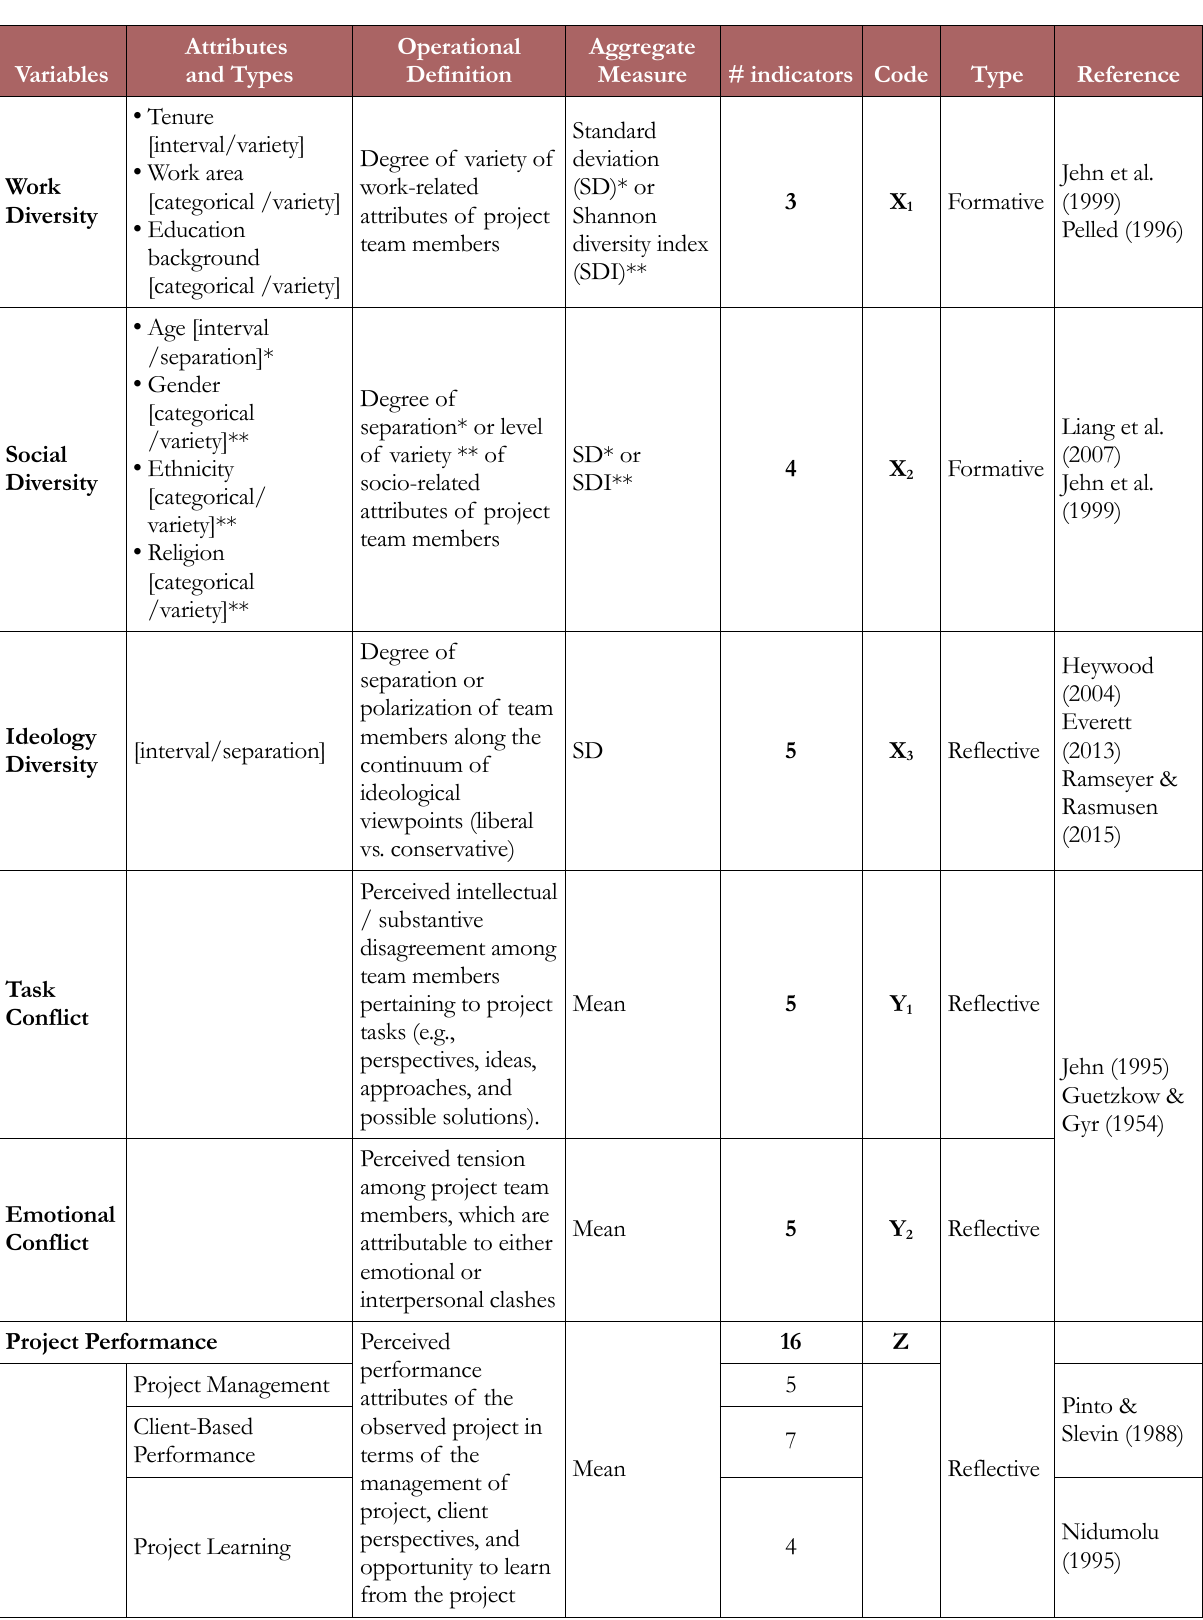
Table 1. Variables, Attributes, and Operational